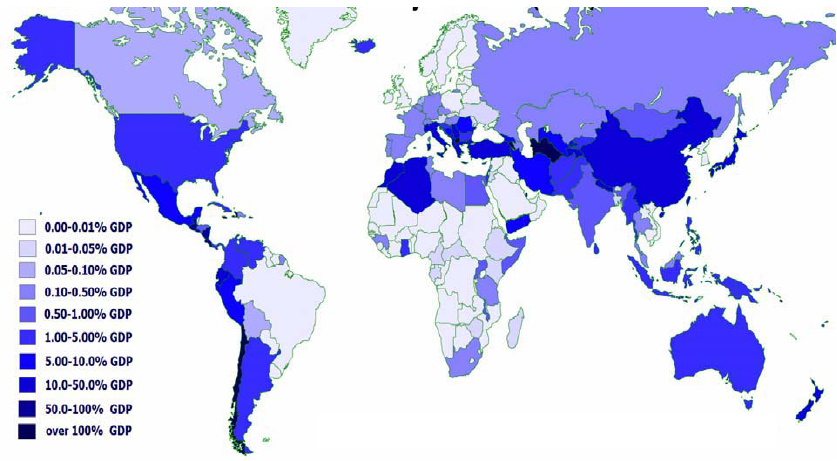
Fig. 14. Economic Losses for each country as a proportion of GDP (PPP) in at the time of disaster cumulative from 1900 to 2010 (Daniell, 2011a).